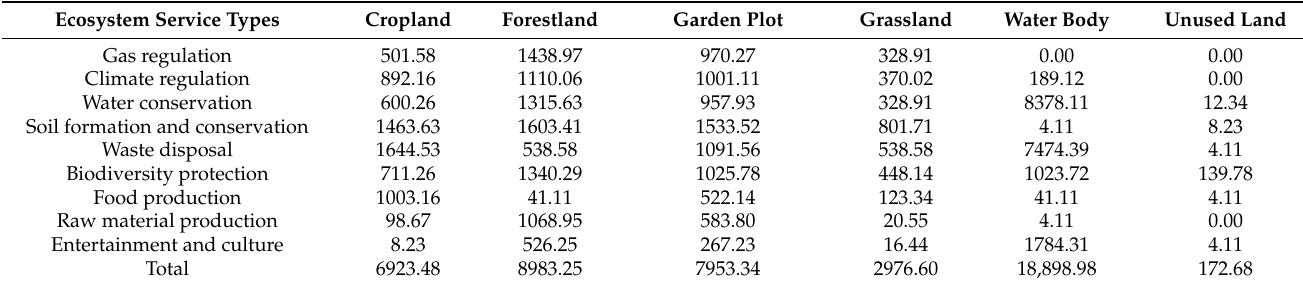
Table 2. Coefficients of ecosystem service value per unit of land area in the Poverty Belt around Beijing and Tianjin, based on previous studies [19,31,32] (unit: CNY/hm 2